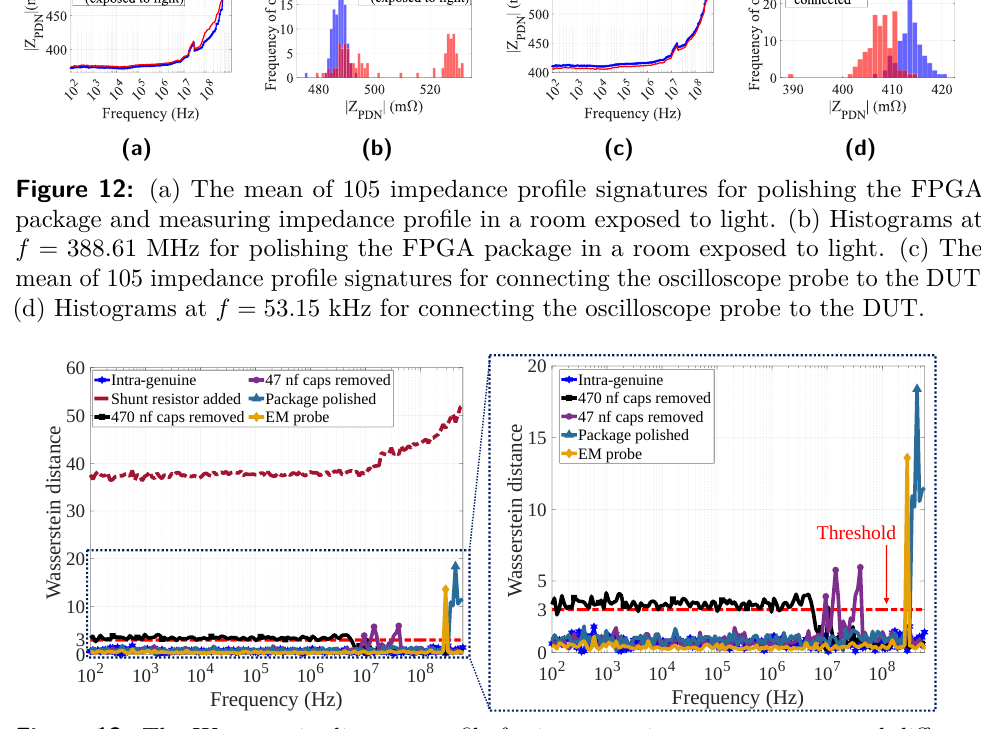
Figure 13: The Wasserstein distance profile for intra-genuine measurements and different attacks over 100 Hz - 588 MHz band (core voltage PDN). The figure on the right shows the zoomed-in view of the left-side figure, excluding the shunt resistor added experiment. only the mean of the measurements but also the variance or the entire shape of the